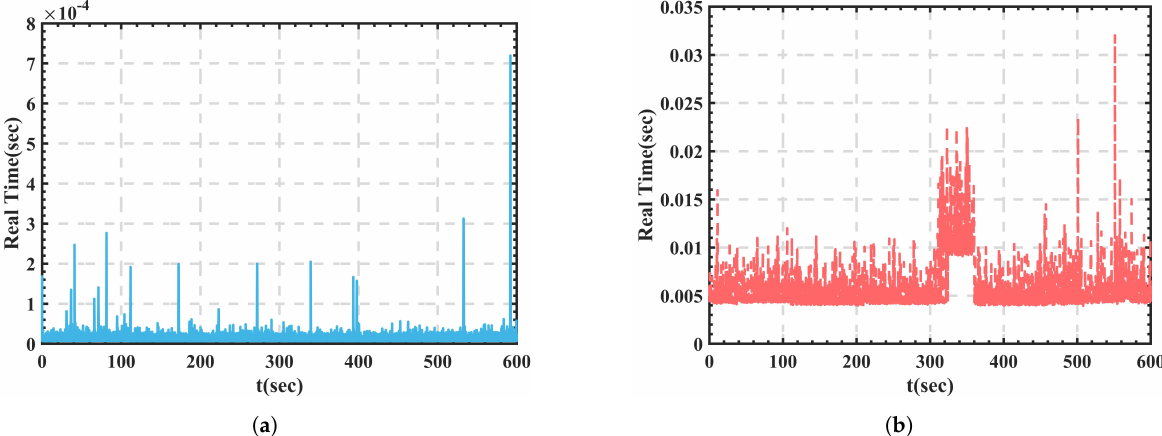
Figure 20. When n y = 7, at each sampling time: ( a ) mpQP-eMPC calculation time; ( b ) tMPC calculation time.